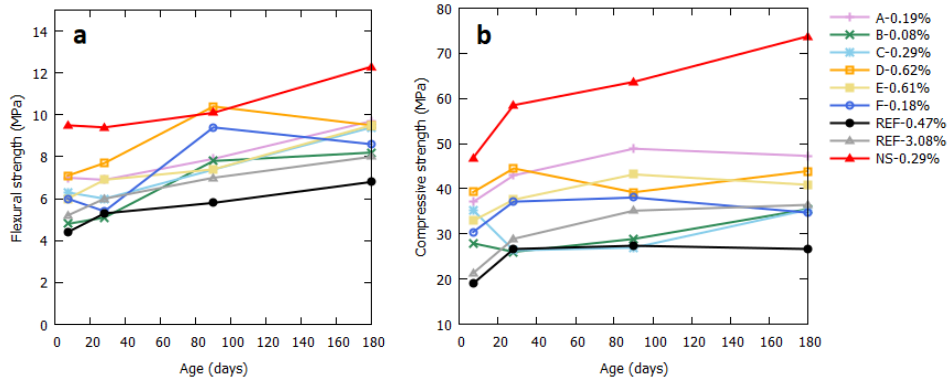
Figure 5. Flexural ( a ) and compressive ( b ) strength of the mortar samples after 7, 28, 90, and 180 days.